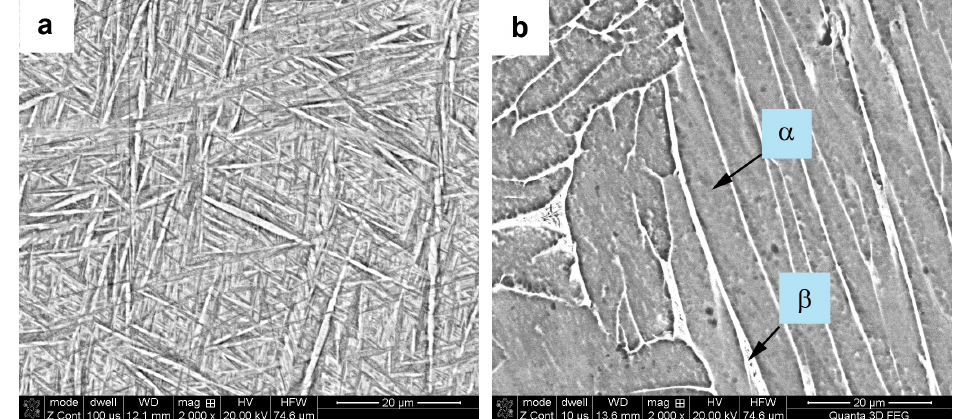
Figure 10. The SEM micrographs of honeycomb components microstructure before ( a ) and after ( b ) heat treatment (1050 °C/2 h).